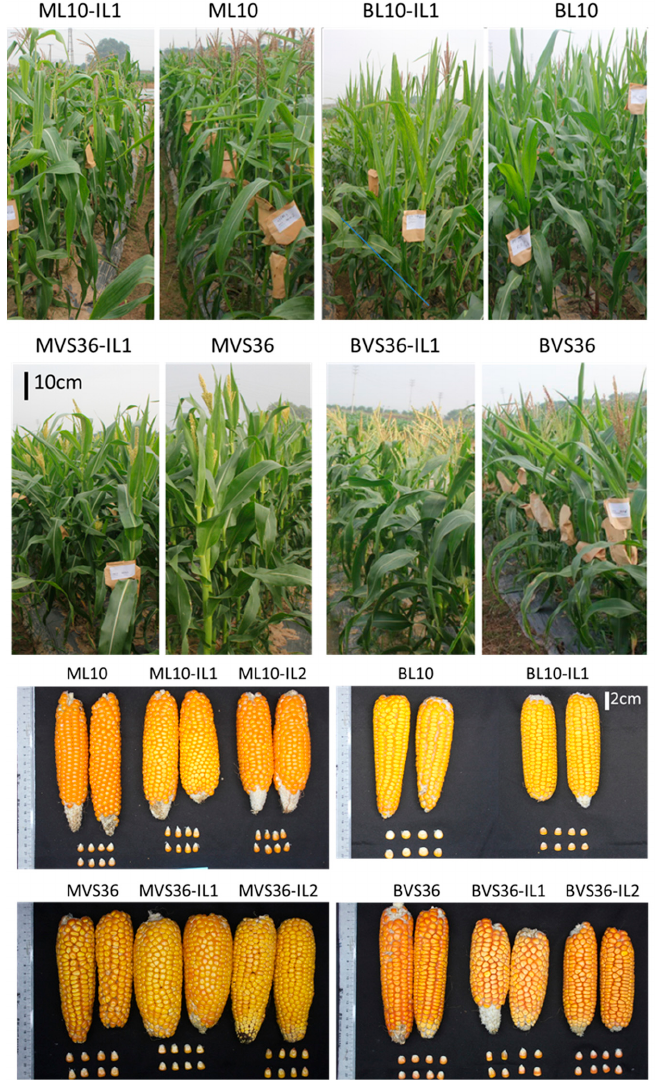
Figure 4. Plants and ears of introgression lines that were homozygous for fea2-1328 at the BC 3 F 3 generation and the corresponding recurrent parents.